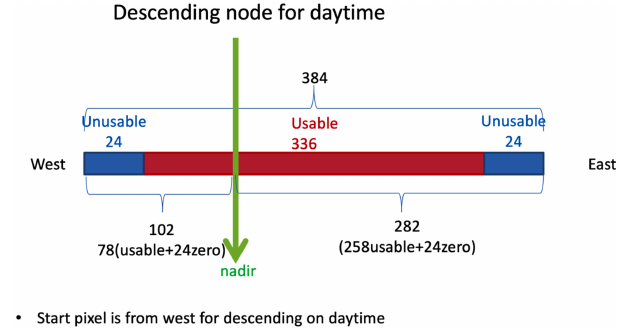
Figure 1. Typical pixel distribution of EarthCARE MSI swath used in this study. When EarthCARE MSI is in its descending mode (moving from north to south), the nadir pixel is basically located around the 102nd pixel counted from the west. However, in actual observation, the location of the nadir will fluctuate slightly accord- ing to the location of the satellite.